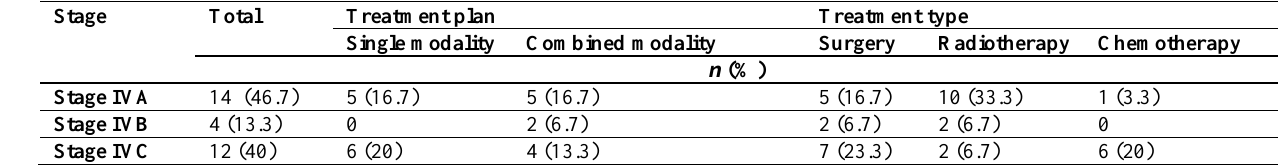
Table 3: Summary of treatment by stage for the 22 treated anaplastic thyroid cancer patients Stage